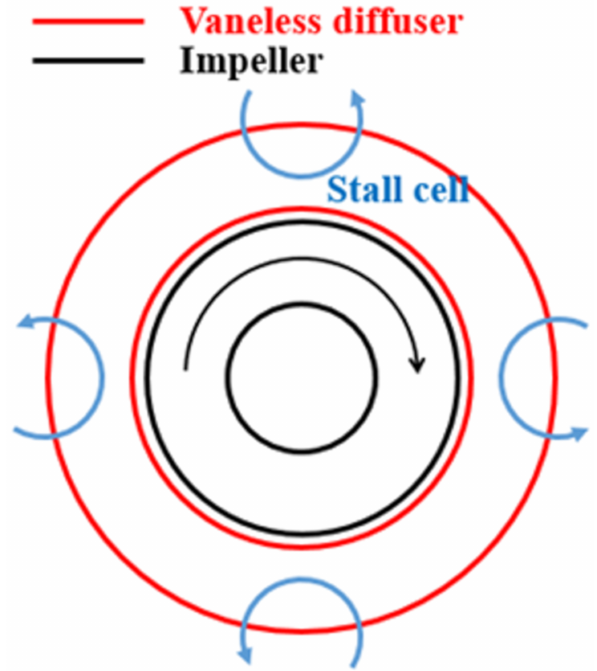
Figure 2. Topology of rotating stall cells in the vaneless di ff user.